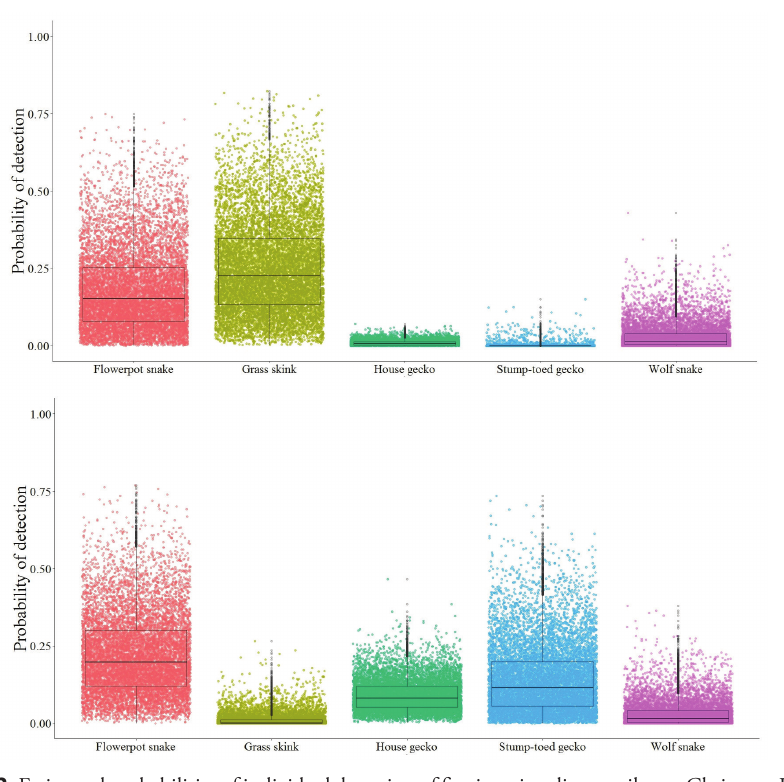
Figure 2. Estimated probabilities of individual detection of five invasive alien reptiles on Christmas Island (Australia) during day time (top panel) and night time surveys (bottom panel). Estimates correspond to the probability of individual detection during a 10-minute survey across the 34 surveying sites. Each dot represents a realisation from 1000